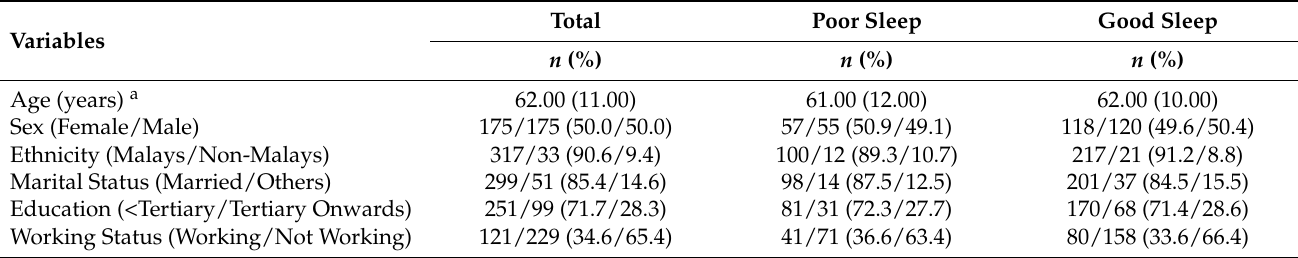
Table 1. Socio-demographic characteristics of participants ( n = 350).